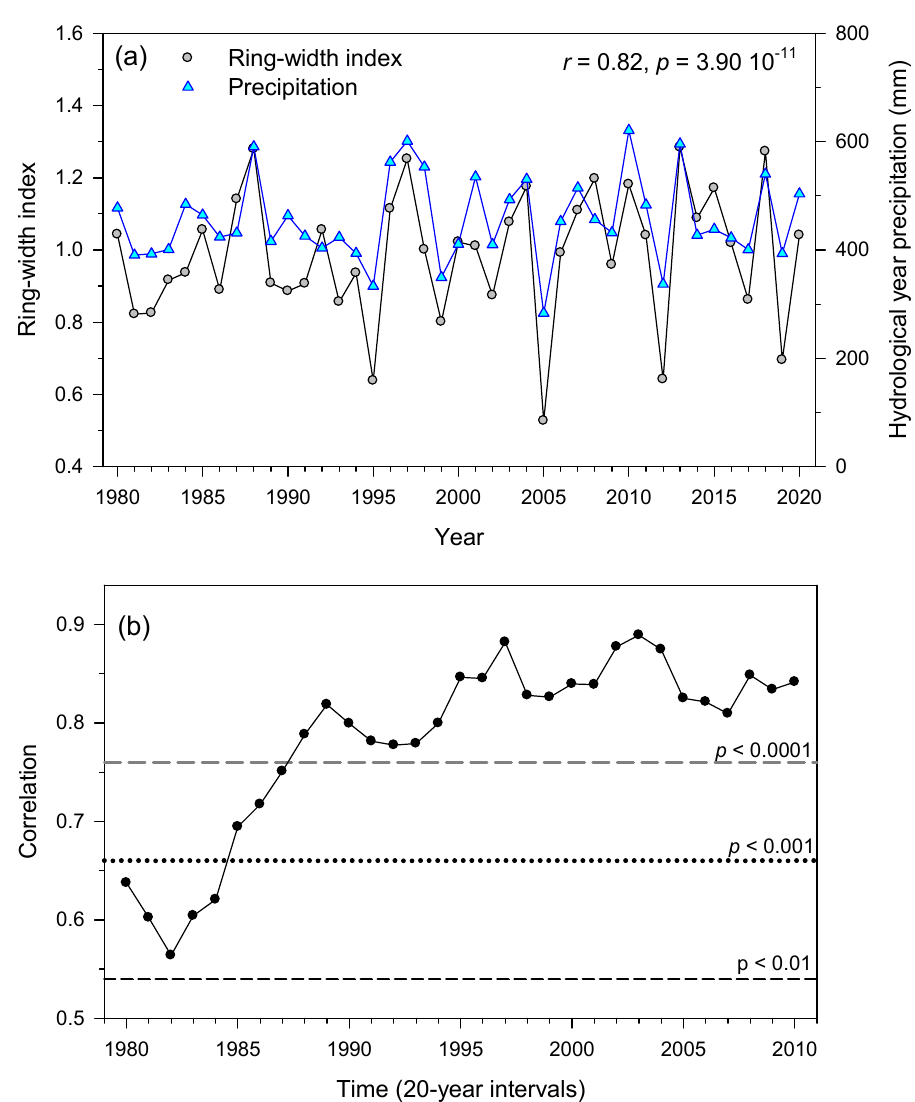
Figure 5. Atlas cedar growth is driven by the total precipitation during the hydrological year ( a ) and this association has strengthened through time ( b ). In the panel ( a ), the ring-width index is the mean of all sites’ series, and the precipitation was computed for the region delimited by coordinates 5.75° W–1.00° E and 37.00°–44.25° N. In the panel ( b ), moving Pearson correlations between the two variables shown in panel ( a ) are calculated considering 20-year moving intervals from 1961 to 2020. The horizontal lines show the significance levels.